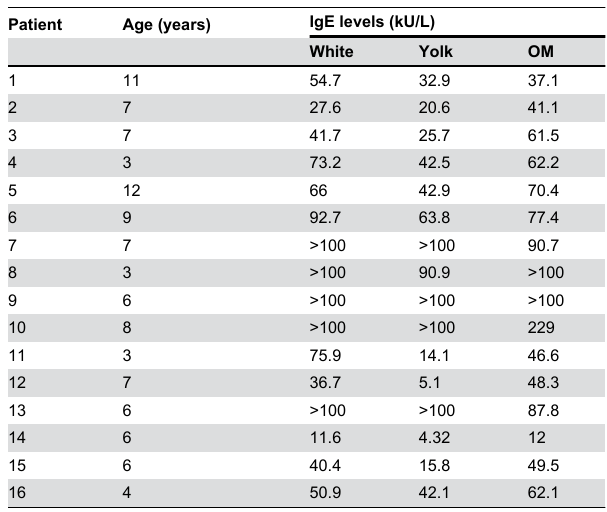
Table 1. Specific IgE levels (kU/L) towards egg white, yolk and ovomucoid of the sera used in the inhibition ELISA, Western blotting, dot blot, and basophil activation experiments.